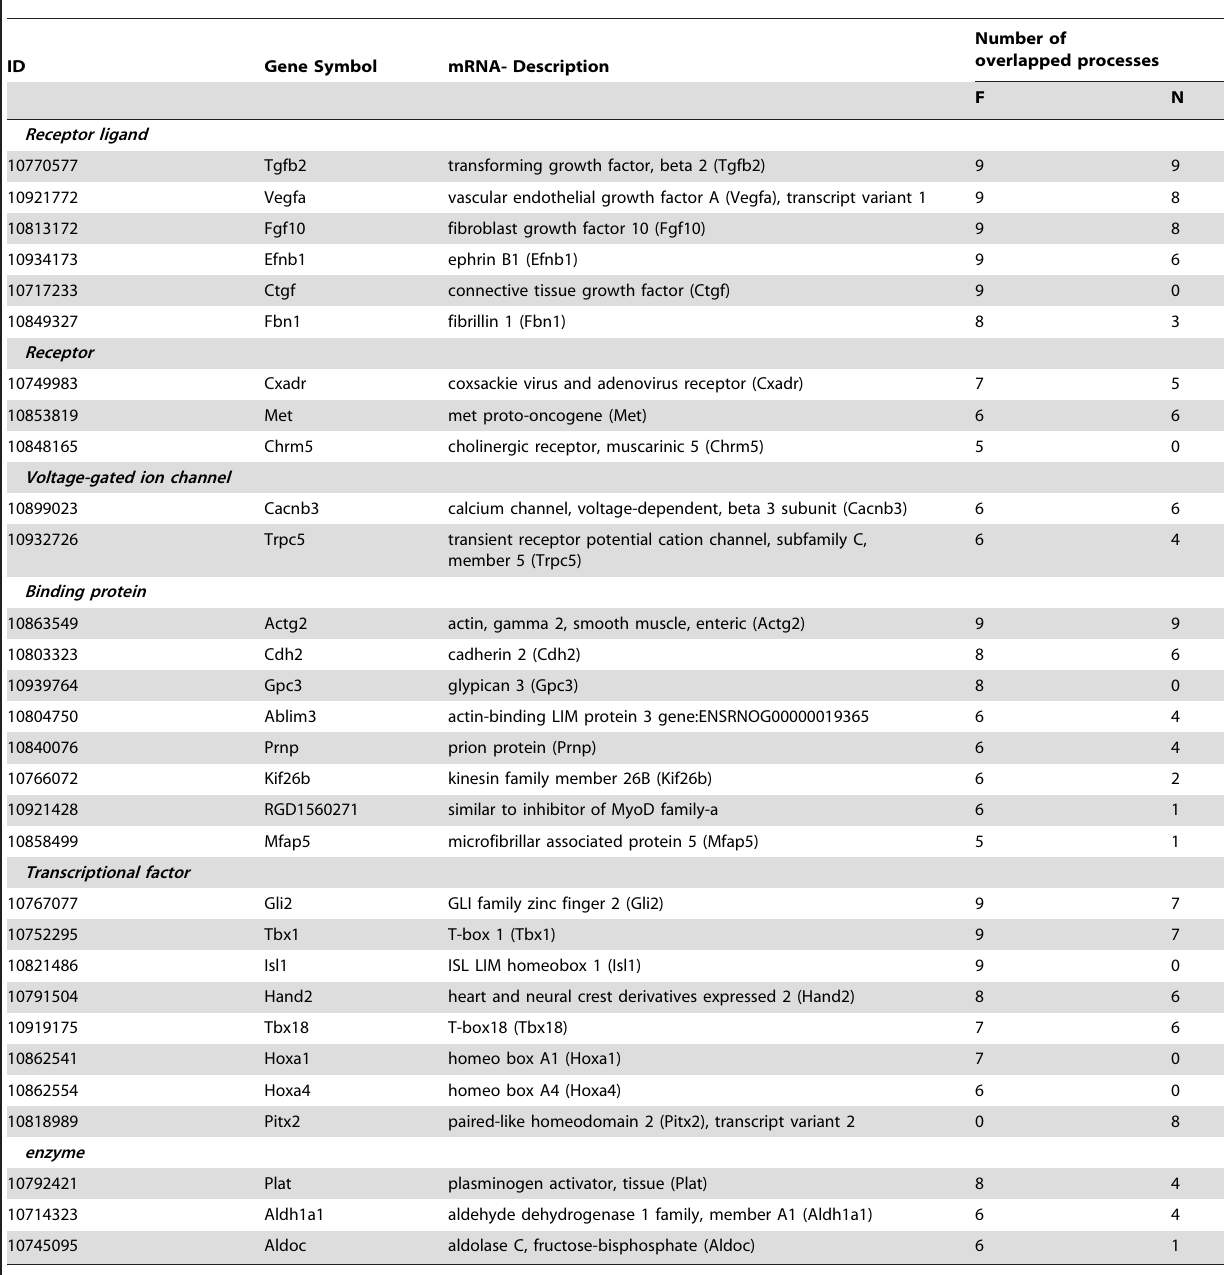
Table 6. Thirty overlapping genes that appeared in more than five processes of the top ten ranking as active genes.